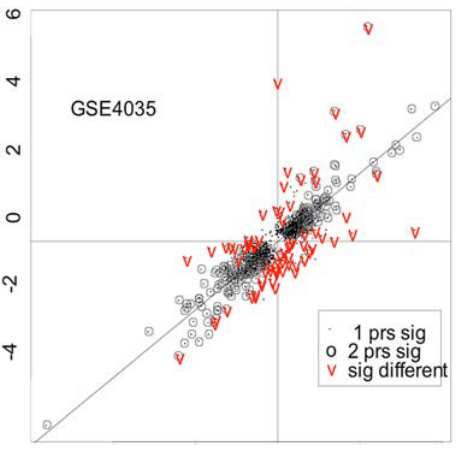
Figure 4. Fold change comparison across redundant probe sets. We first tested each probe set on the array for the brain region effect and identified a list of significant probe sets using FDR 0.005 significance level. We then compared this significant probe set list with the list of genes with two present redundant probe sets according to genome based grouping. For genes with at least one significant probe set, we plotted the two fold changes (on log scale) against each other with random naming of probe set1 (prs1) and probe set2 (prs2) in a gene. Genes with one significant probe set are presented by points. Genes with two significant probe sets are represented by circles. We also tested the two fold changes obtained from each probe set for genes with two redundant probe sets using FDR 0.05 significance level as described in Methods. Genes that show significant difference in their fold changes are represented by red